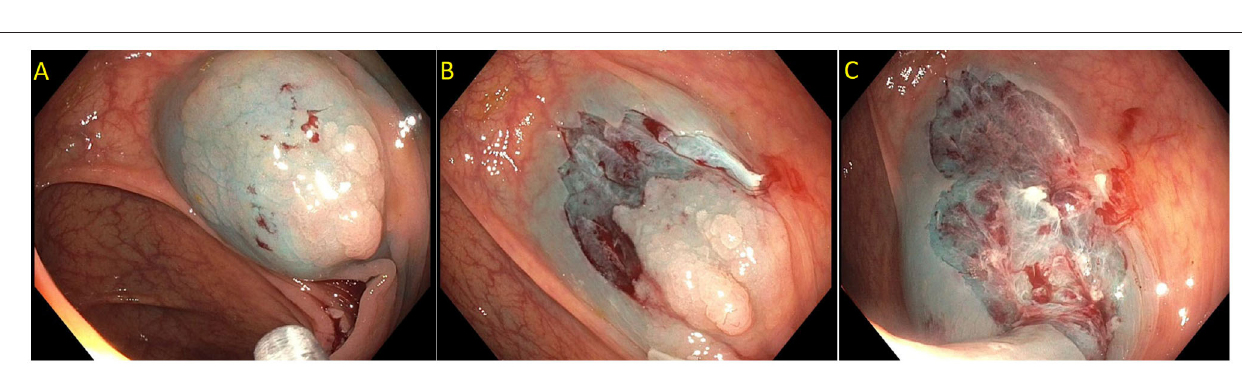
endoscopic resection. Endoscopic recurrence, perforation and bleeding occurred in 13.8, 1.5 and 6.5%, respectively (86). Studies have shown that EMR is not only cost-effective than surgery; it has less morbidity and mortality also ( Table 1 ). It should be considered the first line of treatment for patients with these sessile or lateral spreading large ( ≥ 20 mm) lesions (60,